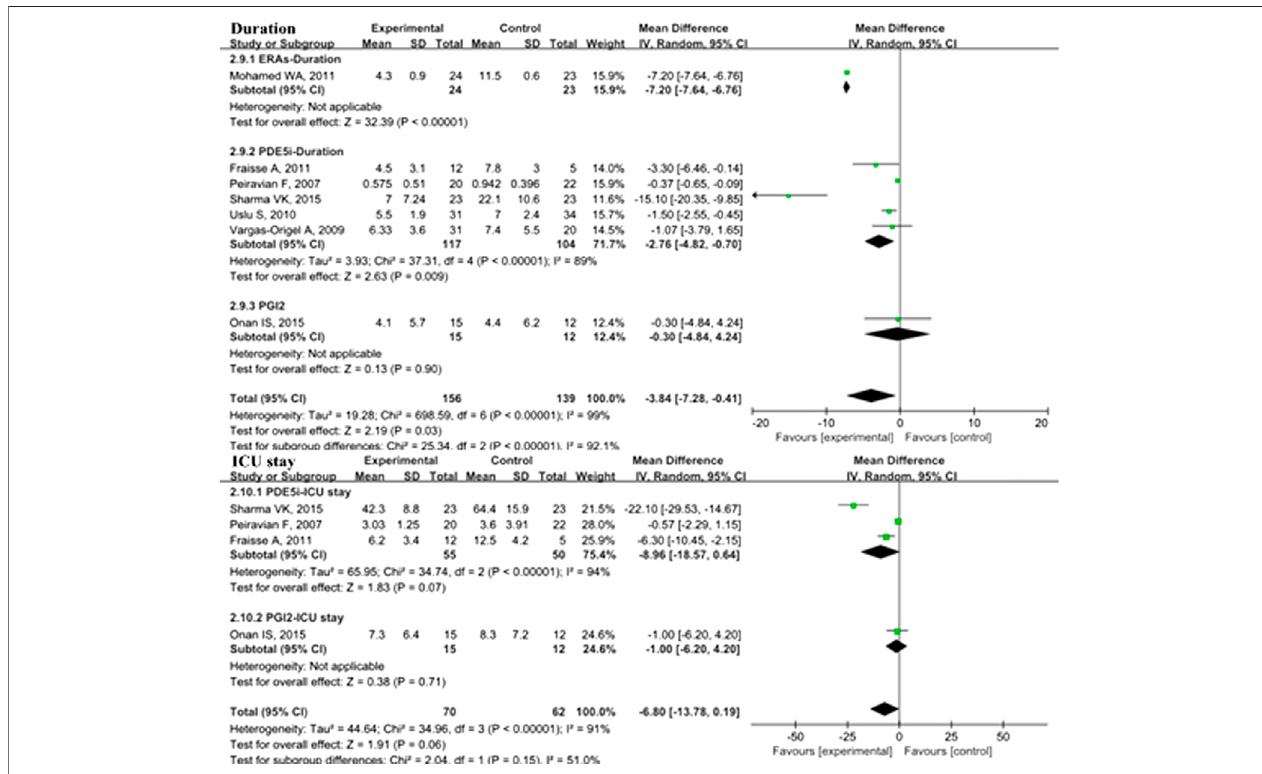
FIGURE 5 | Duration of mechanical ventilation and ICU stay in pediatric PH patients treated with pulmonary vasodilators. Abbreviations: Duration, duration of mechanical ventilation; ICU, intensive care unit. Other abbreviations are de fi ned in Figure 1 .